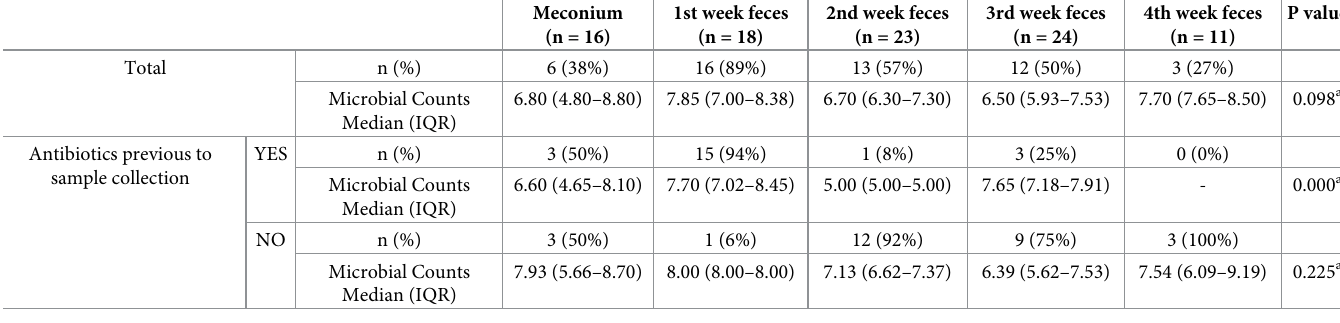
Table 2. Isolation and quantification (log 10 cfu/g) of S . epidermidis in meconium and fecal samples the recruited